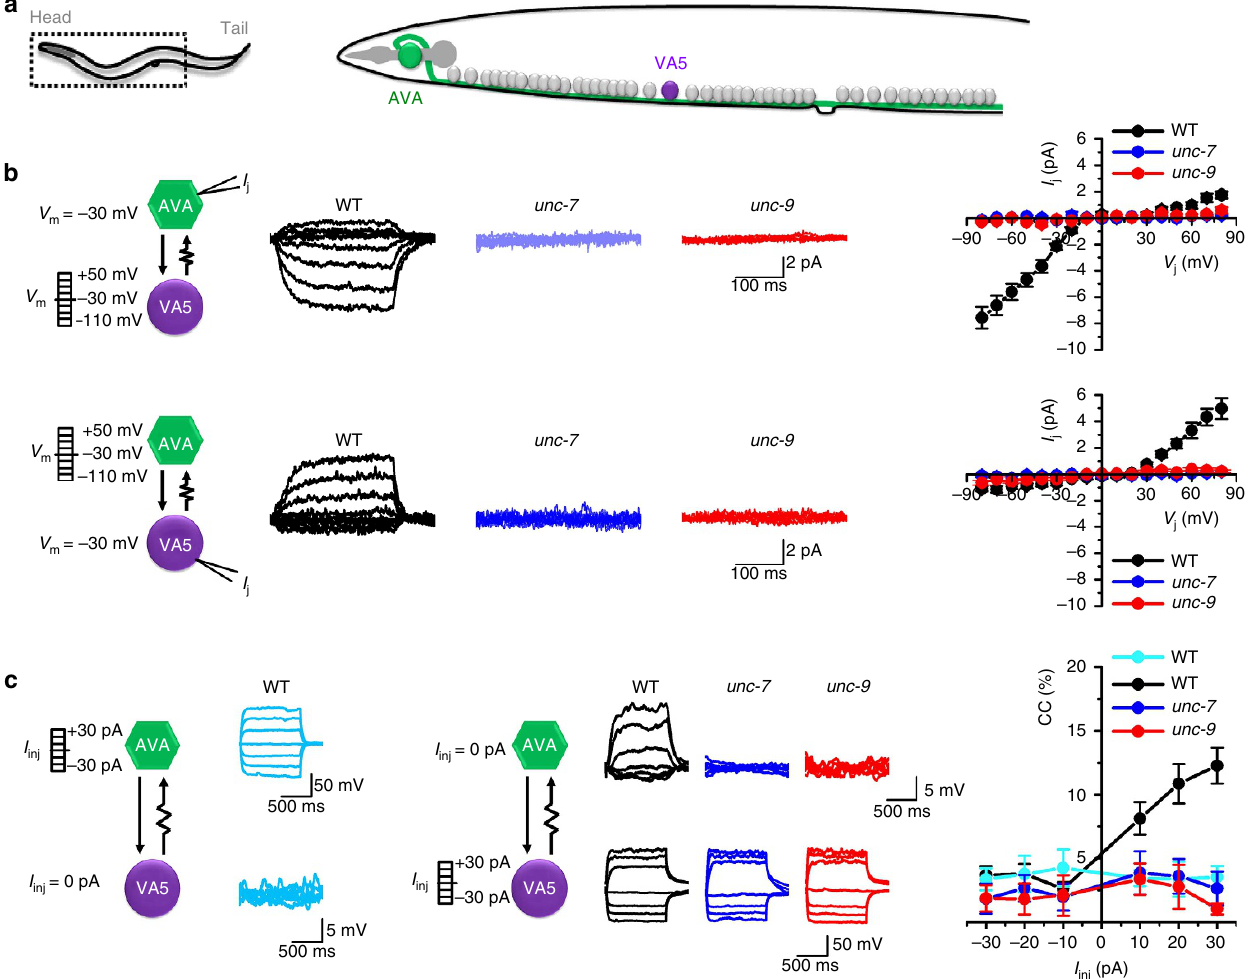
Figure 6 | Gap junctions between AVA and VA5 only allow antidromic junctional current ( I j ) and require the innexins UNC-7 and UNC-9 to function. ( a ) Diagram showing the locations of AVA and VA5. ( b ) I j between AVA and VA5, strongly rectifying in the AVA direction, is present in wild type (WT, n ¼ 10) but not in either unc-7(e5) ( n ¼ 8) or unc-9(fc16) ( n ¼ 8). I j was recorded from one neuron held constantly at (cid:2) 30mV (neuron #1) while the other neuron (neuron #2) was stepped to various membrane voltage ( V m ) from a holding voltage of (cid:2) 30mV. V j ¼ V m of neuron #1 (cid:2) V m of neuron #2. Whole- cell membrane currents of the neuron receiving the voltage steps are not shown for clarity. ( c ) Current injection ( I inj ) into VA5 but not AVA causes significant depolarization of the uninjected neuron in WT ( n ¼ 10). I inj into VA5 has little effect on AVA in the unc-7 ( n ¼ 8) and unc-9 ( n ¼ 8) mutants. Coupling coefficient (CC) is the ratio of V m changes of the uninjected neuron over the injected